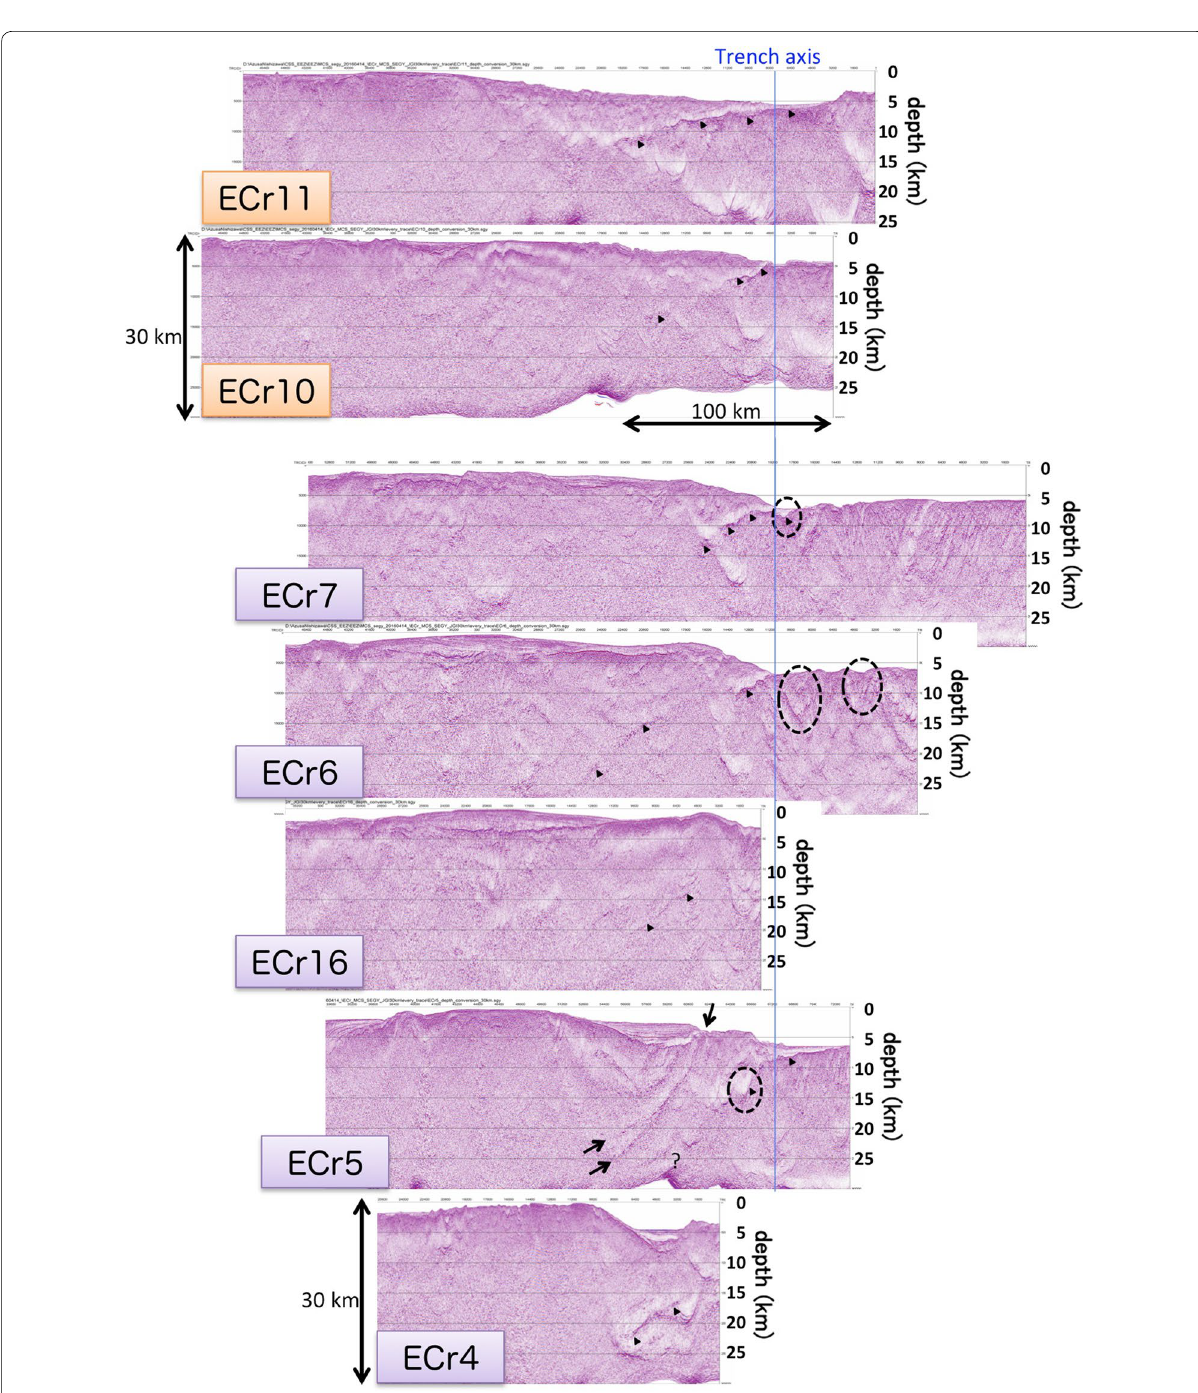
Fig. 3 Multichannel seismic profiles (depth-converted section) for the across-trench survey lines. The vertical blue line shows the positions of the trench axis. The triangles and dashed ellipses indicate the estimated positions of the subducting Philippine Sea plate interface and the fracture zone, respectively. The arrows in ECr5 indicate a possible splay